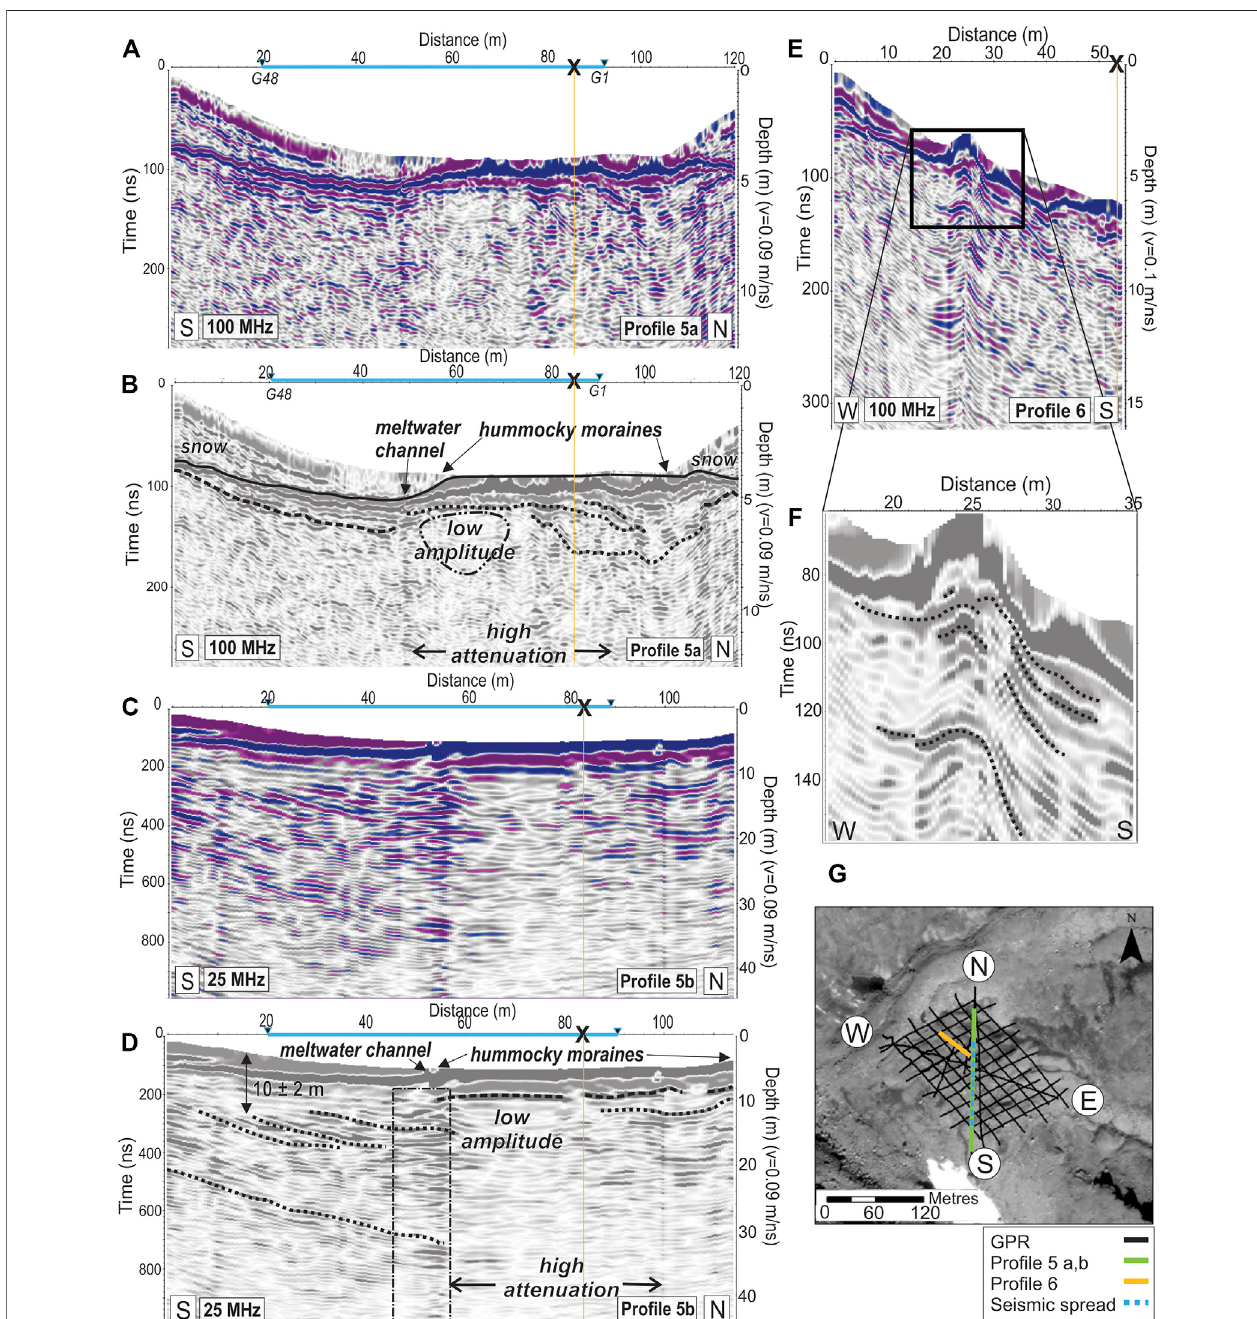
FIGURE 8 | Processed GPR data from the Hummocky Site. (A) Pro fi le 5a: 100 MHz pro fi le along the seismic survey line and (B) its interpretation. (C) Pro fi le 5b: 25 MHz pro fi le along the seismic survey line and (D) its interpretation. (E) Pro fi le 6: 100 MHz pro fi le over section E1 ( Figure 1C ). (F) Enlarged view of the moraine from Pro fi le6. (G) SatelliteimagewithdiagramofGPRpro fi leorientationsattheHummockySite.InB,D&F,solidlinesshowsnow-groundinterface,dashedanddottedlines delineate continuous and discontinuous re fl ections, respectively. Dot-dashed boxes outline columns of high amplitude re fl ections. G1 and G48 indicate the approximate locations of geophones 1 and 48. X and yellow lines indicate approximate crossover location between Pro fi les 5 and 6.